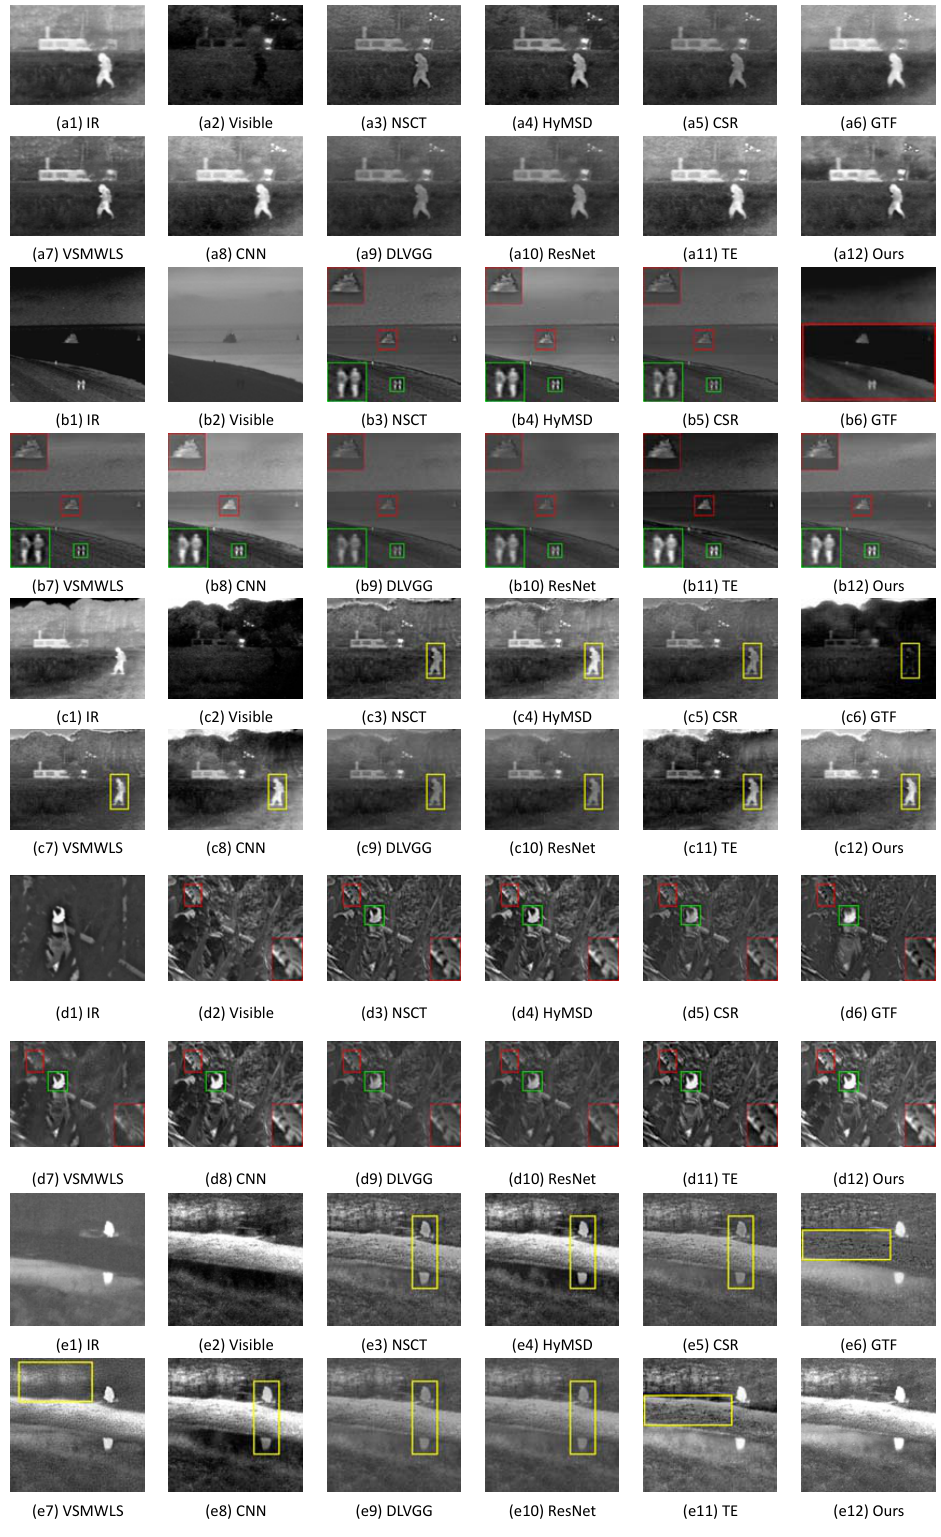
Figure A3. Fusion performances of various methods on the IR and visible image pairs. From top to bottom: ‘Pedestrian’, ‘Kayak’, ‘T1’, ‘T2’, and